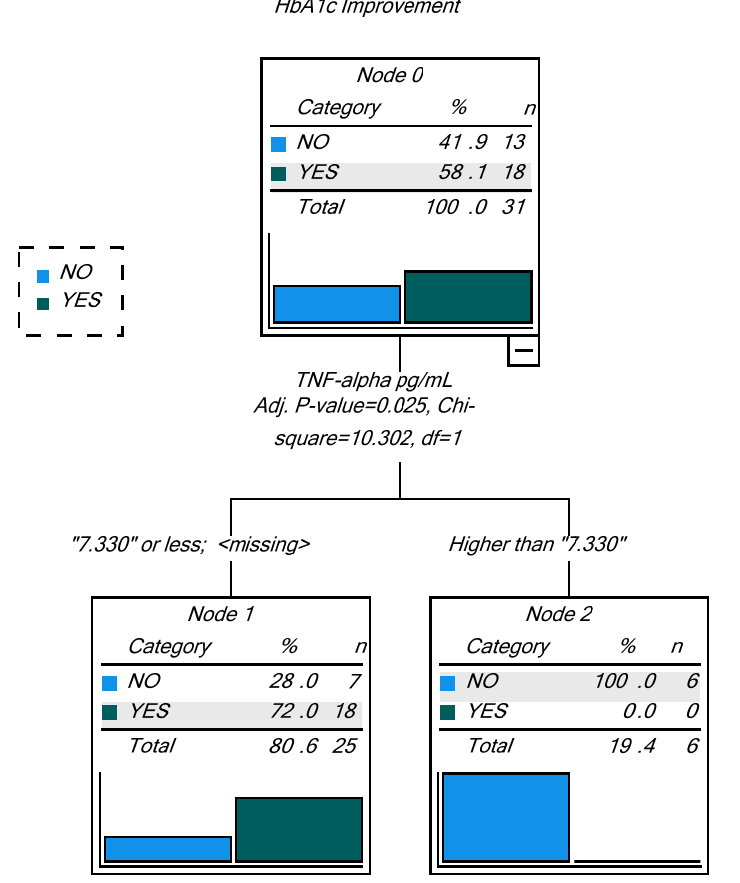
Figure 2. Decision tree on HbA1c improvement as dependent variable. Classification is 77% correct using basal TNF- α as predictor variable.